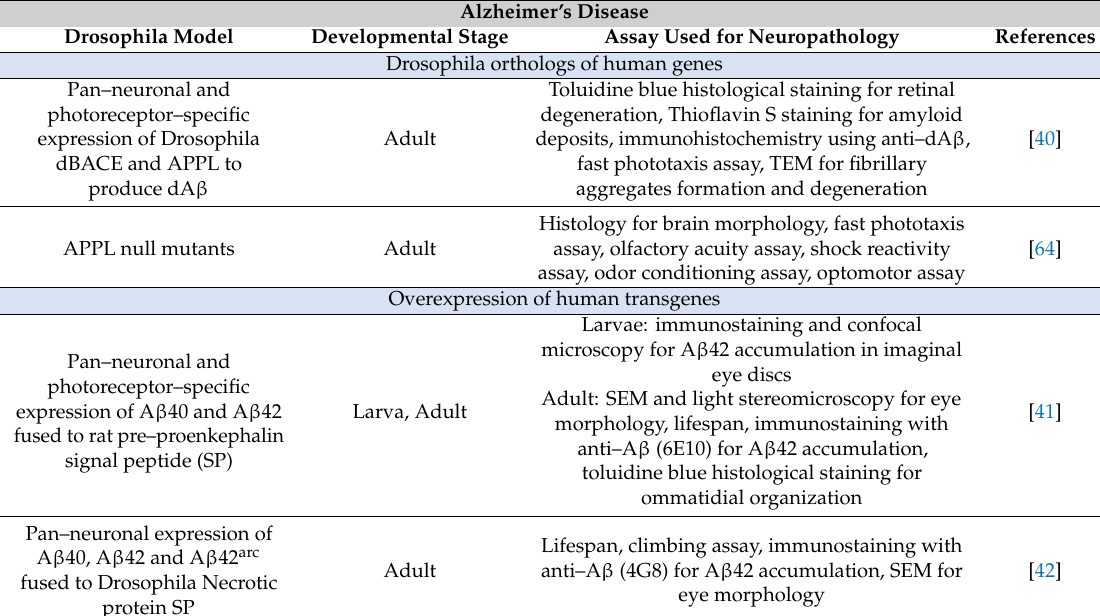
Table 1. Drosophila models of Alzheimer’s